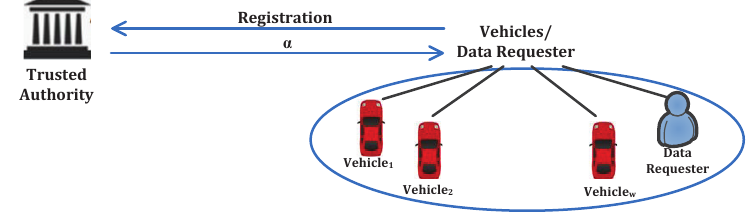
Figure 2. Registration and secret sharing among the data requester and